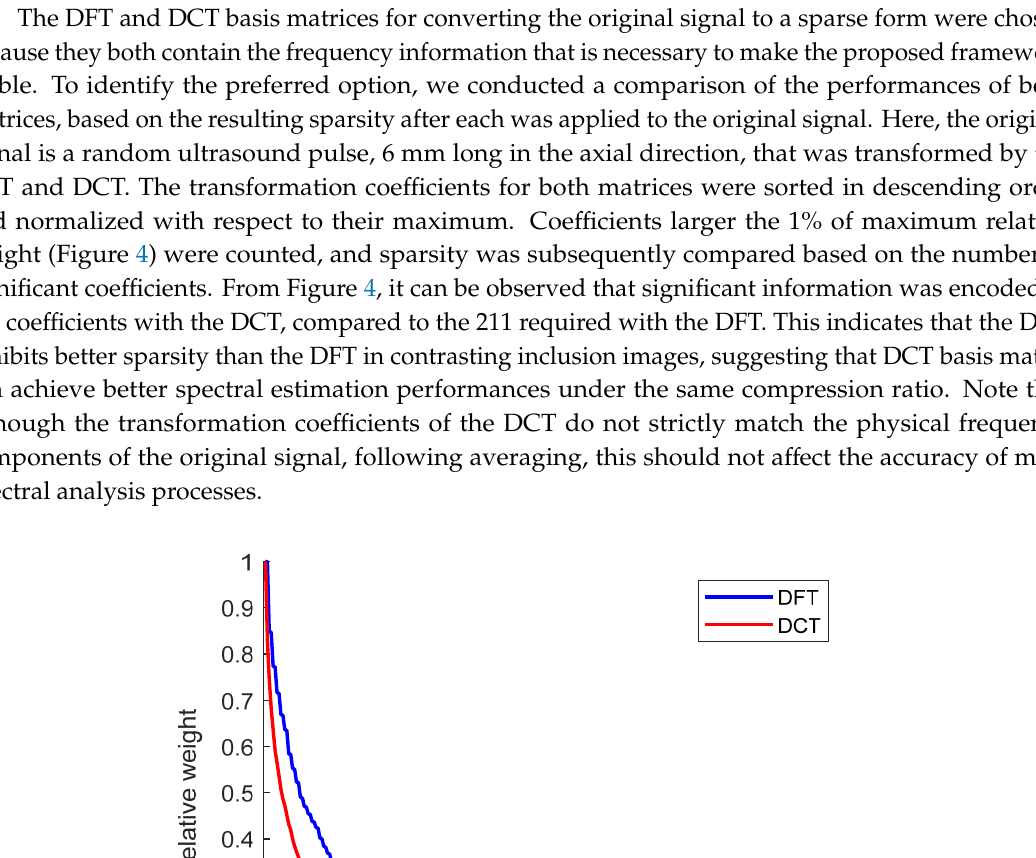
( b ) Figure 5. Results of time-domain analysis of compressed sensing (CS) data using the DCT basis matrix: ( a ) Envelope detection for the original signal propagating through the p12 phantom, using the traditional and proposed frameworks for CS data. ( b ) Magnified view of section highlighted in 6(a). For further quantitative analysis, quality of B-mode images was compared by the weighted mean and standard deviation for original data and reconstructed CS data with traditional and the 4